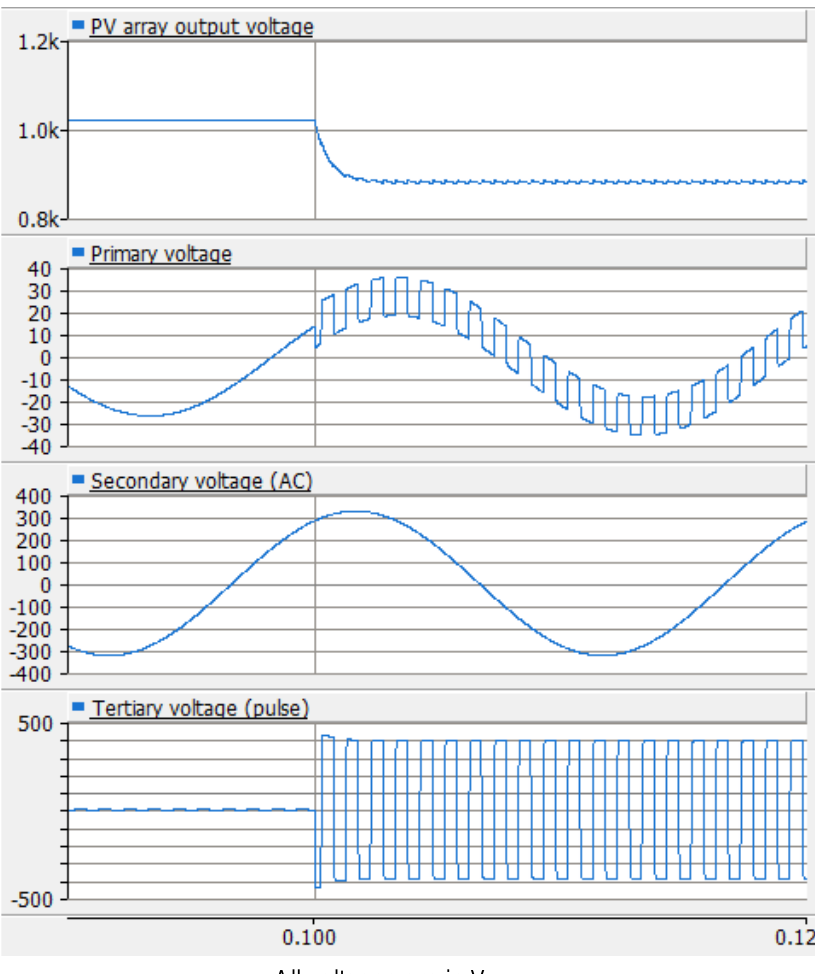
All voltages are in V